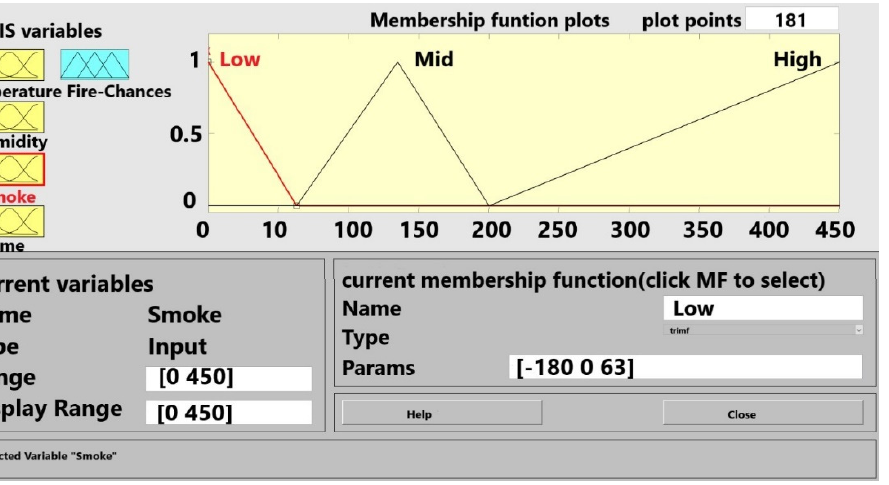
Figure 20. Membership Function for Smoke sensor